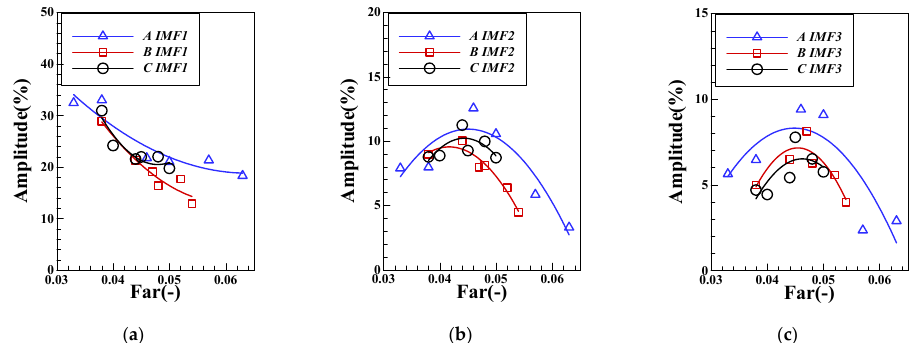
Figure 19. Variation of the proportion of pulsation peak energy of each order component of DP: ( a ) IMF1; ( b )IMF2; ( c ) IMF3.